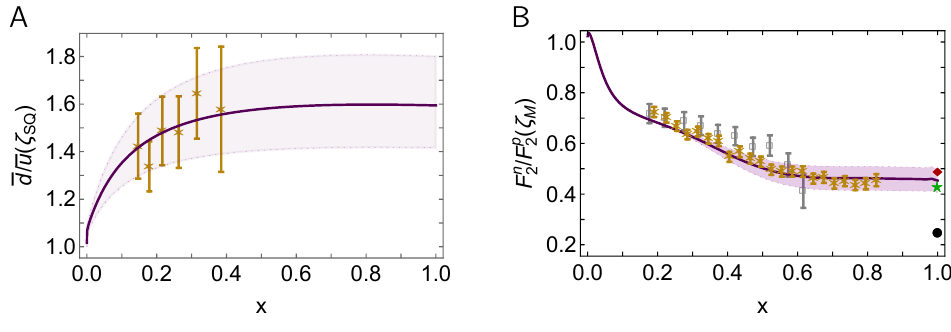
Figure 26. Left panel ( A ): Ratio of light antiquark DFs. Data: Reference[443] (E906). CSM result (solid purple curve) obtained from valence quark DFs in Figure 23 after evolution to ζ 2 = ζ 2 30GeV 2 [135]. The shaded band expresses the impact of a ± 25% variation in the strength of Pauli blocking. Right panel ( B ): Neutron-to-proton structure function ratio. Data: [444] (BoNuS)—open grey squares; [445] (MARATHON)—gold asterisks. Contemporary CSM results (solid purple curve) obtained from valence quark DFs in Figure 23 after evolution to ζ = ζ M = 2.7GeV [134,135]. Other predictions: green star—helicity conservation in the QCD parton model [412,446,447]; red diamond— large- x estimate based on Faddeev equation solutions [448]; retaining only scalar diquarks in the proton wave function, which produces a large- x value for this ratio that lies in the neighbourhood of the filled circle [449,450]. The band surrounding the CSM curve expresses the response to a ± 5% variation in the size of axial vector diquark contributions to the proton charge. It is only noticeable on the valence quark